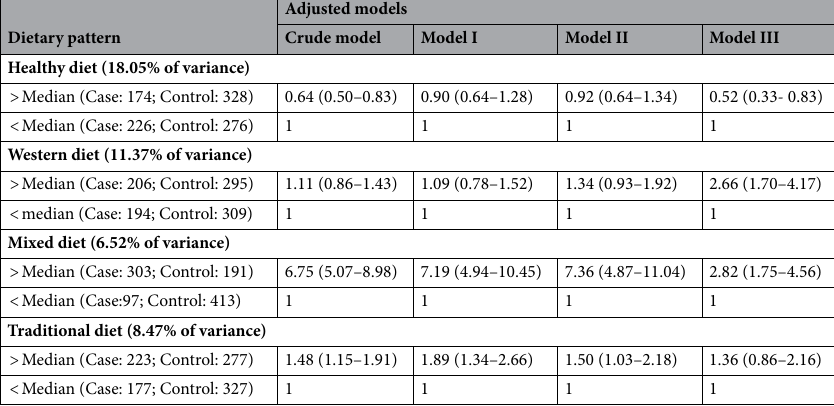
Table 3. Multivariable adjusted odds ratio (OR) and 95% confidence interval (CI) for infertility in tertiles of dietary pattern scores. Model I: Adjusted for age, BMI, and physical activity. Model II: Adjusted for model I plus education, use of pesticides, smoking, and socioeconomic status (SES). Model III: Adjusted for model II plus